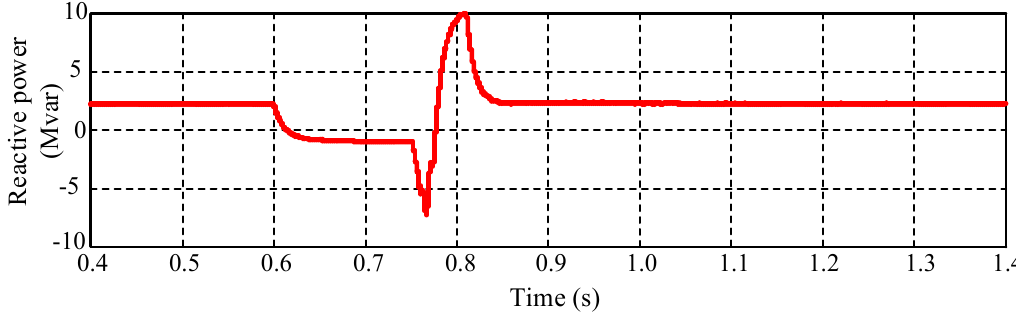
Figure 20. Reactive power injected from STATCOM.